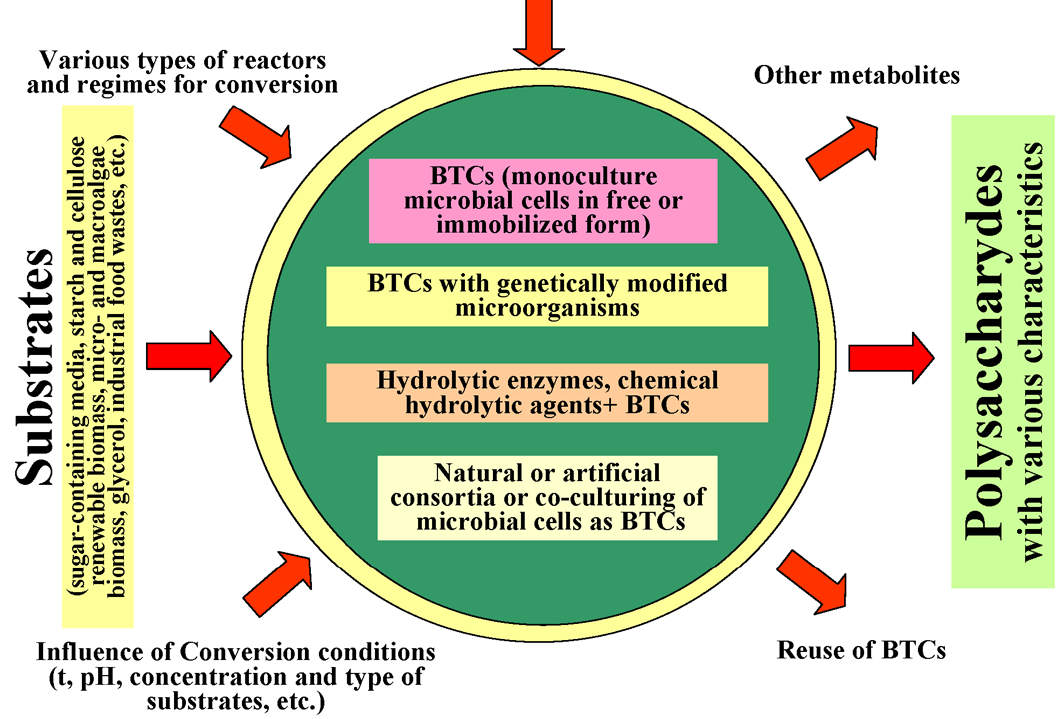
Figure 1. Main variants of BTCs used for producing microbial EPSs from various sources.